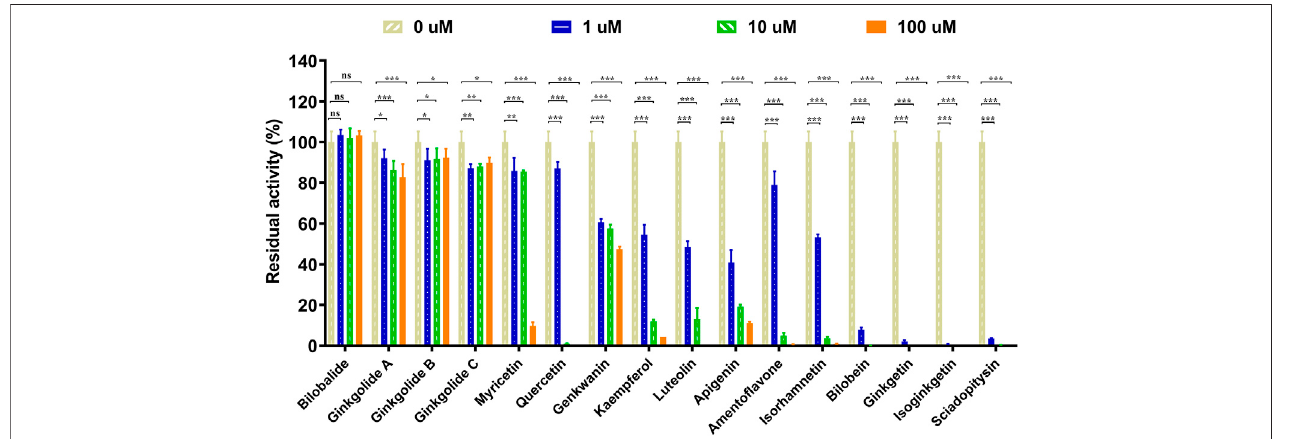
FIGURE 3 | The dose-dependent inhibition curves of bilobetin (A) , isoginkgetin (B) , sciadopitysin (C) and ginkfetin (D) on NHPN- O -glucuronidation in HeLa- UGT1A1 cells. The data were expressed as the means of triplicate determinations.